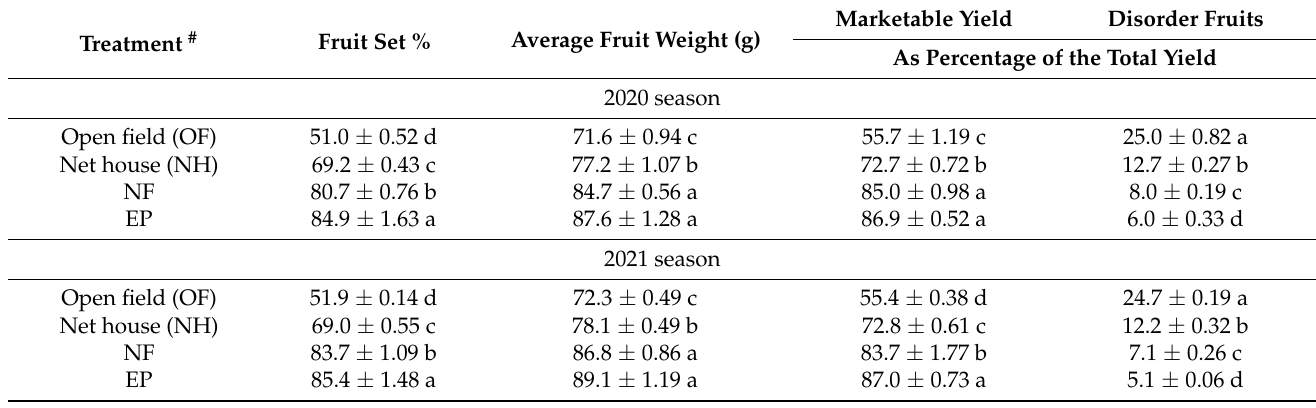
Table 2. Modified walk-in tunnels compared to open-field cultivation to reduce heat stress on tomato plant affecting fruit set, fruit weight, percentages of marketable yield and fruit disorders of tomato. Marketable Yield Disorder Treatment # Fruit Set % Average Fruit Weight (g)